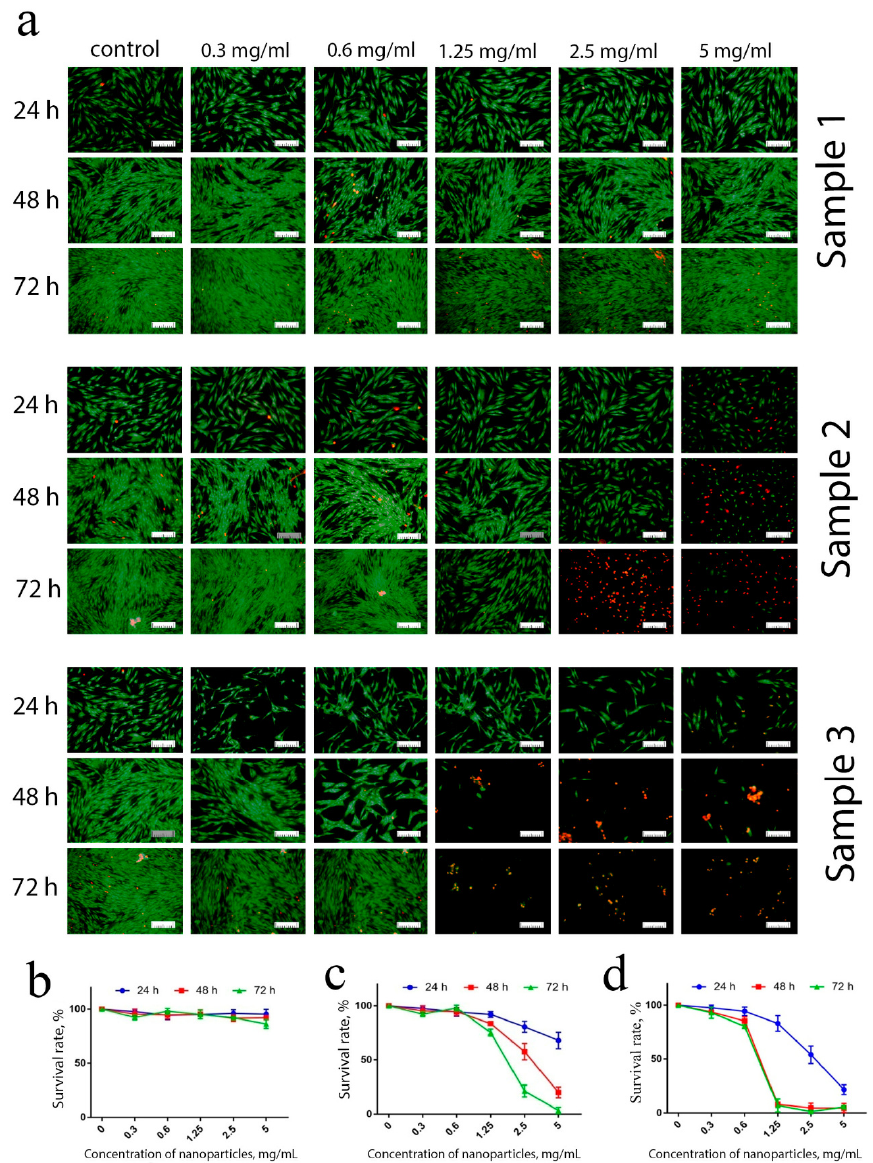
Figure 5. Live/dead assay of hMSc after incubation with Ce 0.8 Gd 0.2 O 2 − x nanoparticles. Micrographs ( a ) and quantification ( b – d ) of viable/dead hMSc after 24, 48 and 72 h of cultivation with Ce 0.8 Gd 0.2 O 2 − x nanoparticles (0.3–5 mg/mL). All the images were taken at the same magnification, the scale bar is 100 µ